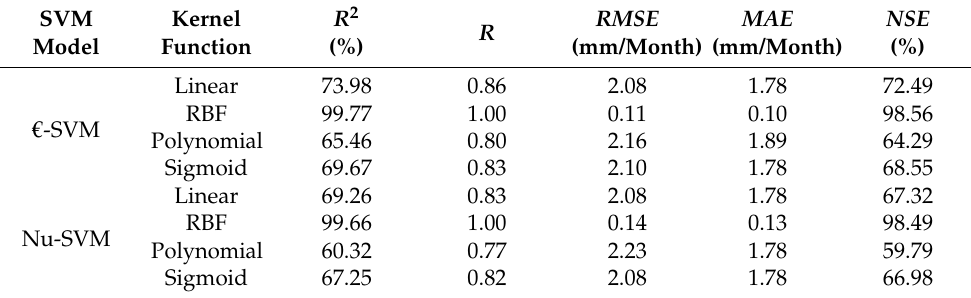
Table 5. Results of the applied SVM model at each kernel function (training period). SVM Model